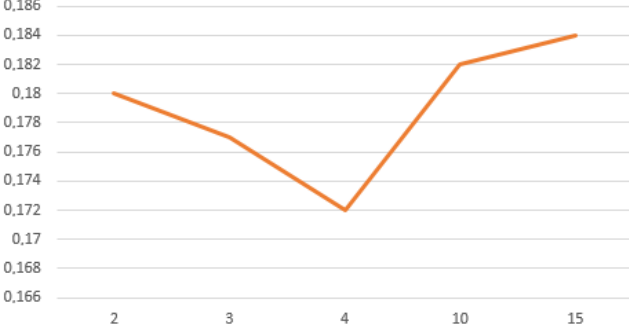
Figure 5. Relative Error (RE) representation for Decision Trees (DT) during the optimization parameters process: the values tested for DT maximal depth ( X -axis) and the RE obtained values ( Y -axis).